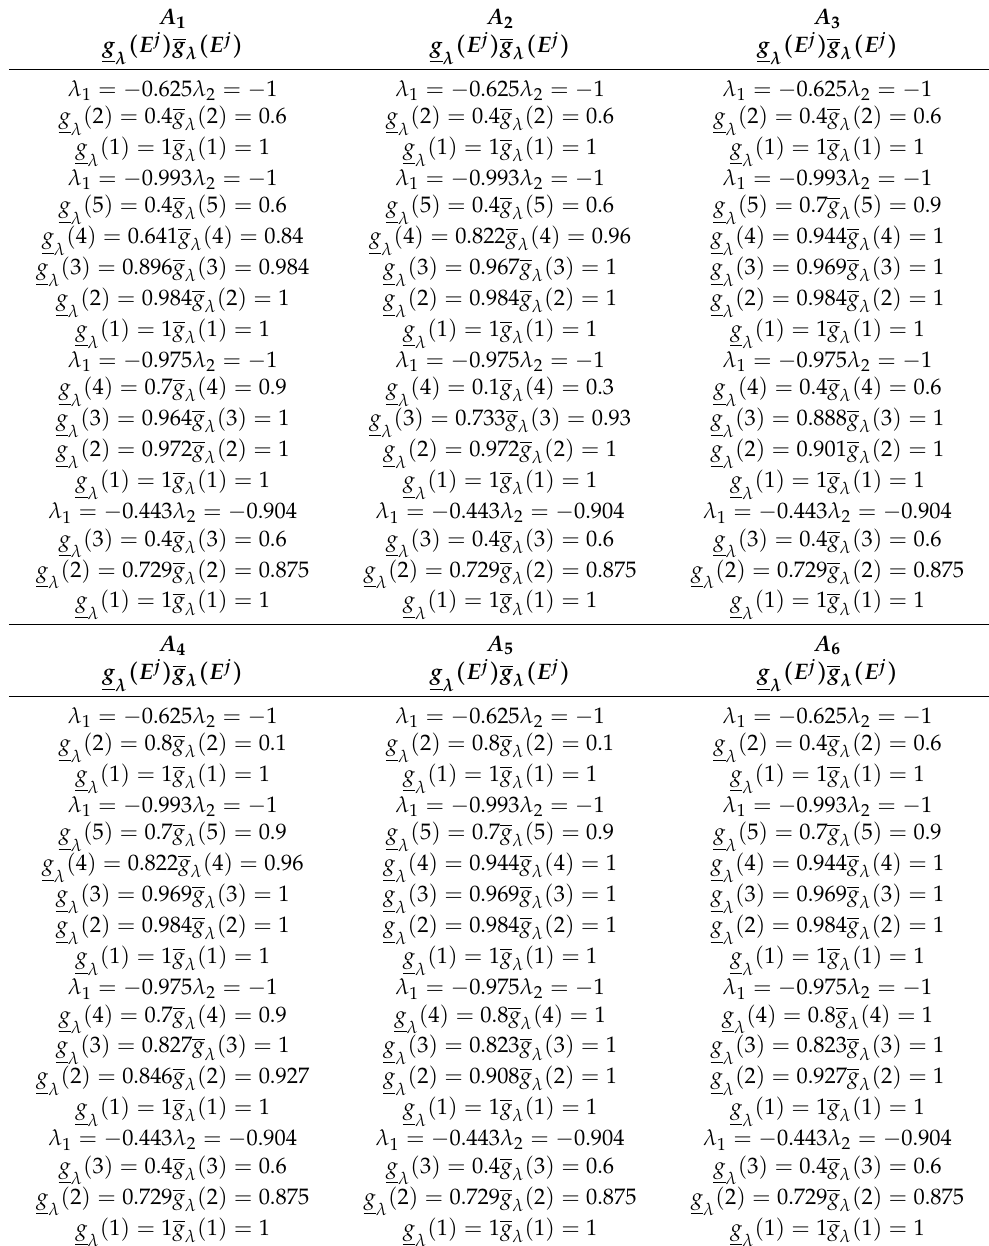
Table 5. The values of fuzzy measure sub-criteria for α =